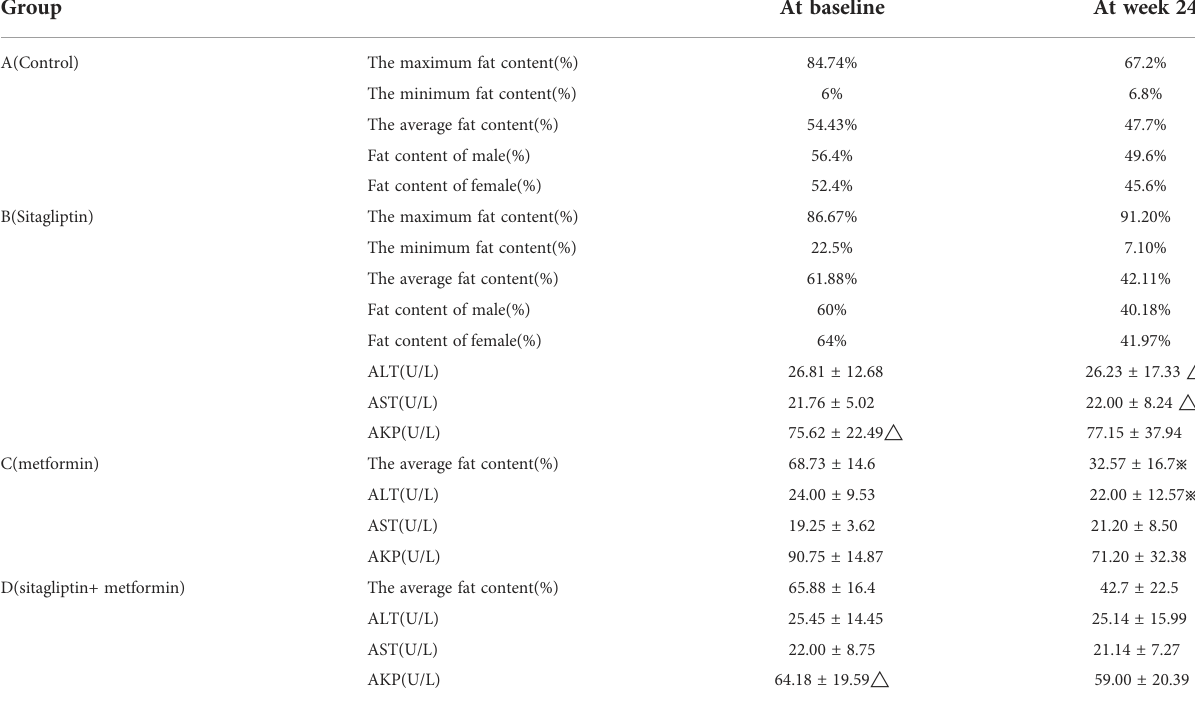
TABLE 2 Comparison of the intrahepatic lipid and liver enzymes between groups.